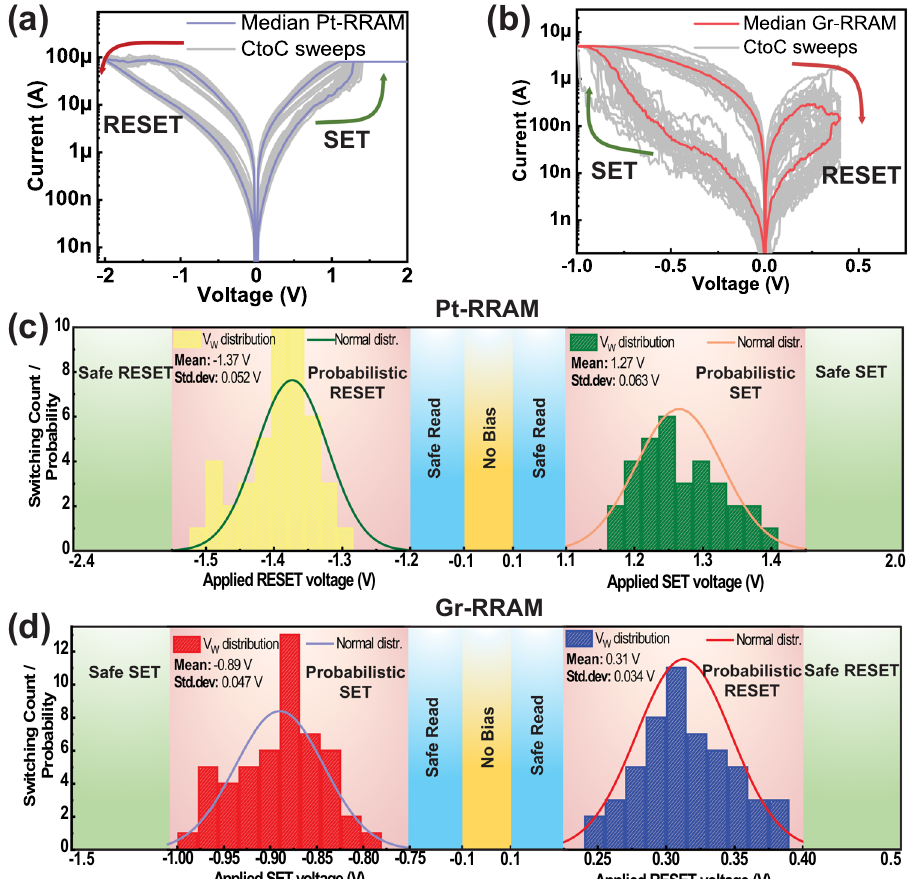
Fig. 2 The programming scheme based on the switching characteristics. a, b Illustration of cycle-to-cycle variation in DC I-V characteristics of a Pt-RRAM, where the median curve is shown in blue, and b Gr-RRAM, where the median curve is shown in the red lines. c, d Programming and reading protocols based on experimental results for c Pt-RRAM and d Gr-RRAM devices for further implementation in 3D VRRAM array